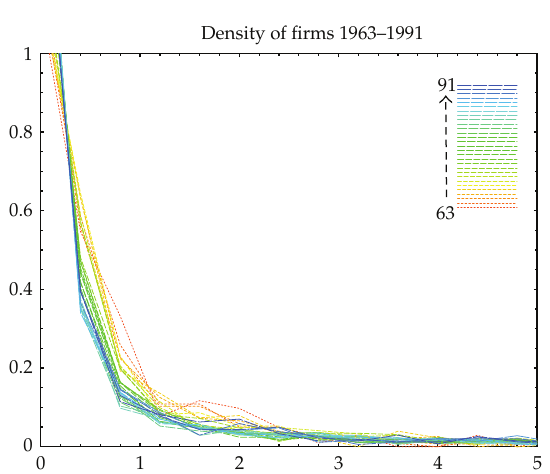
Figure 5: PDF of the (cid:3) normalized (cid:6) netcap from year 1960 to 1991. Normalization is done so that average netcap is one for each year. Data for di ff erent years are plotted in di ff erent hue and dashing as in the